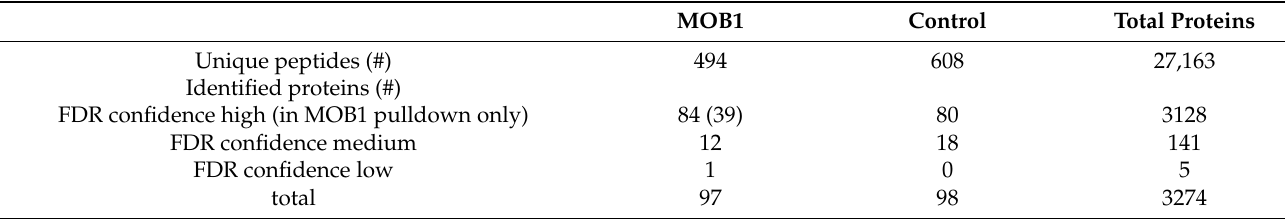
Figure 6. Evaluation of the MOB1 BioID system. ( A ) Western blot using streptavidin-HRP confirmed the in vivo protein biotinylation by the BirA*-recombinant proteins. Ctrl and MOB1 protein extracts present substantially higher amounts of biotinylated proteins when biotin is added to the culture medium, compared to wild-type RH tachyzoites and to when no biotin is supplied. Numbers on the left represent molecular mass in kDa. ( B ) Evaluation of the precipitation of the BioID assay using streptavidin-HRP. The precipitation successfully isolated biotinylated proteins from control and MOB1 protein extracts of three biological replicates. Numbers on the left represent molecular mass in kDa. ( C ) A principal component analysis of the detected peptides shows a clear clustering of Ctrl and MOB1 pull-downs according to their biological replicate group. The first factor (PC 1) accounts for 98.5% of the variance between samples. Ctrl, FLAG-BirA*; MOB1, FLAG-BirA*-MOB1. Table 1. Overall statistics of proteome dataset.